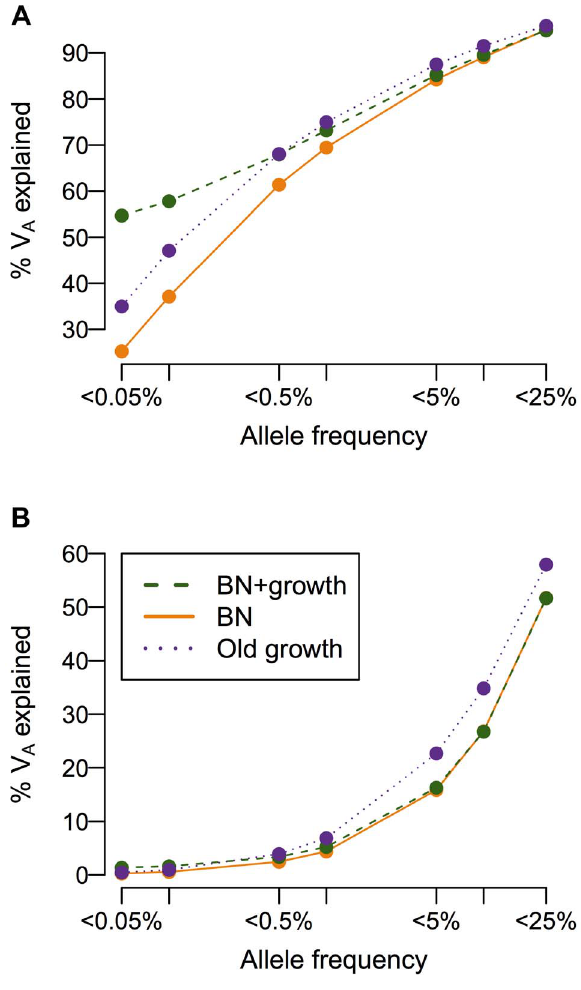
Figure 4. Cumulative distribution of the amount of the additive genetic variance of a trait ( V A ; y -axis) explained by SNPs segregating below a given frequency in the population ( x - axis). ( A ) A SNP’s effect on the trait is correlated with its effect on fitness ( t =0.5). Note that the population that experienced recent growth (green; BN + growth) has a higher proportion of V A accounted for by low-frequency SNPs ( , 0.1% frequency) than the populations that did not recently expand (orange and purple; BN and Old growth). ( B ) A SNP’s effect on the trait is independent of its effect on fitness ( t =0). Note that less of V A is accounted for by low-frequency variants than when the trait is correlated with fitness ( A ). Here h 2 M =70 kb.